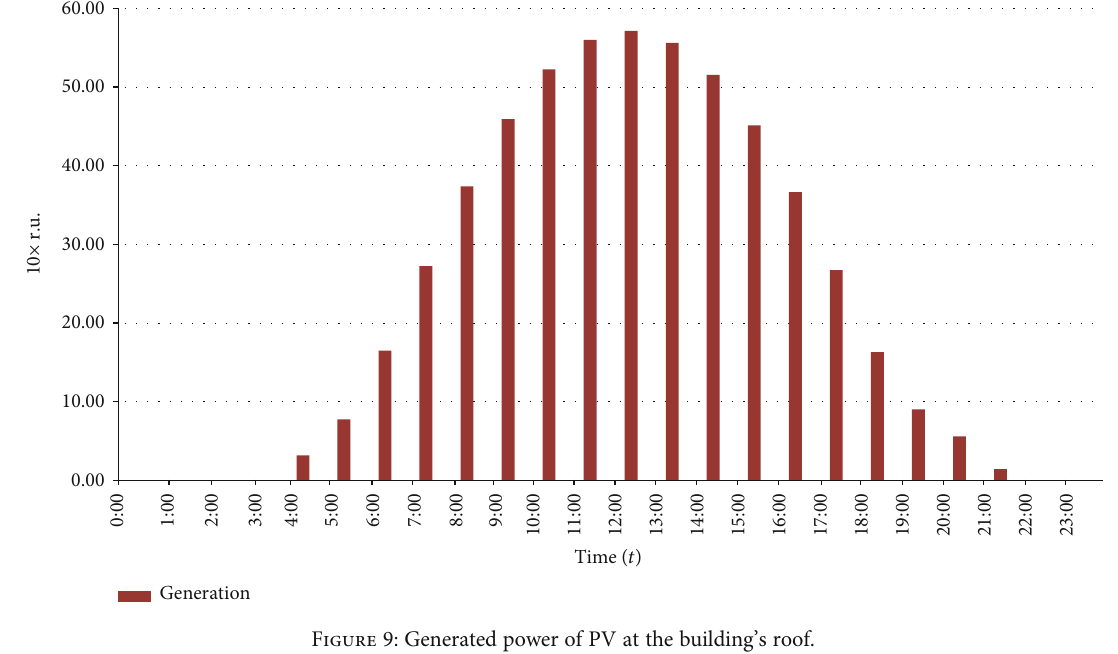
Figure 9: Generated power of PV at the building ’ s roof.